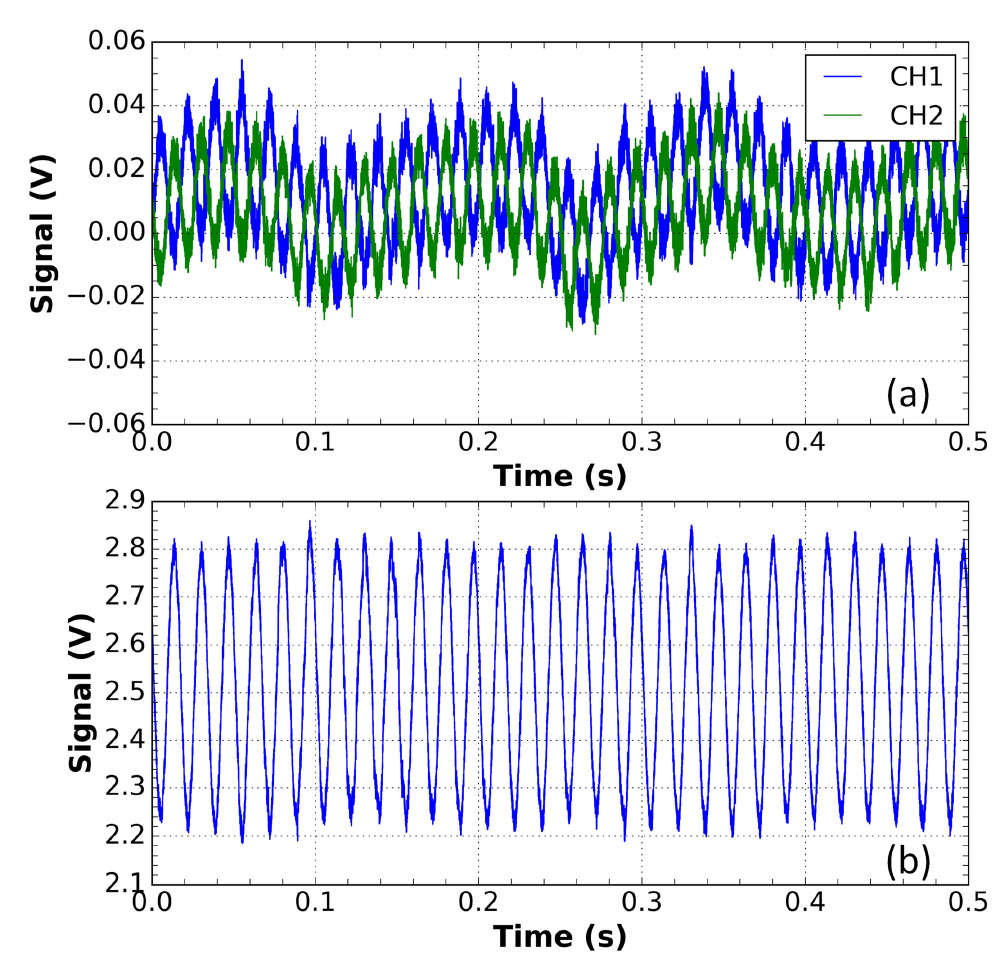
Figure 11. Measurements for the sensor inside the DWDM network. ( a ) Waveforms of the CH1 and CH2 channels of the voltage sensor output in the presence of a disturbance with an applied voltage of 9.56 kV. These signals were subtracted to compensate for the amplitude variation; ( b ) the result of this subtraction.